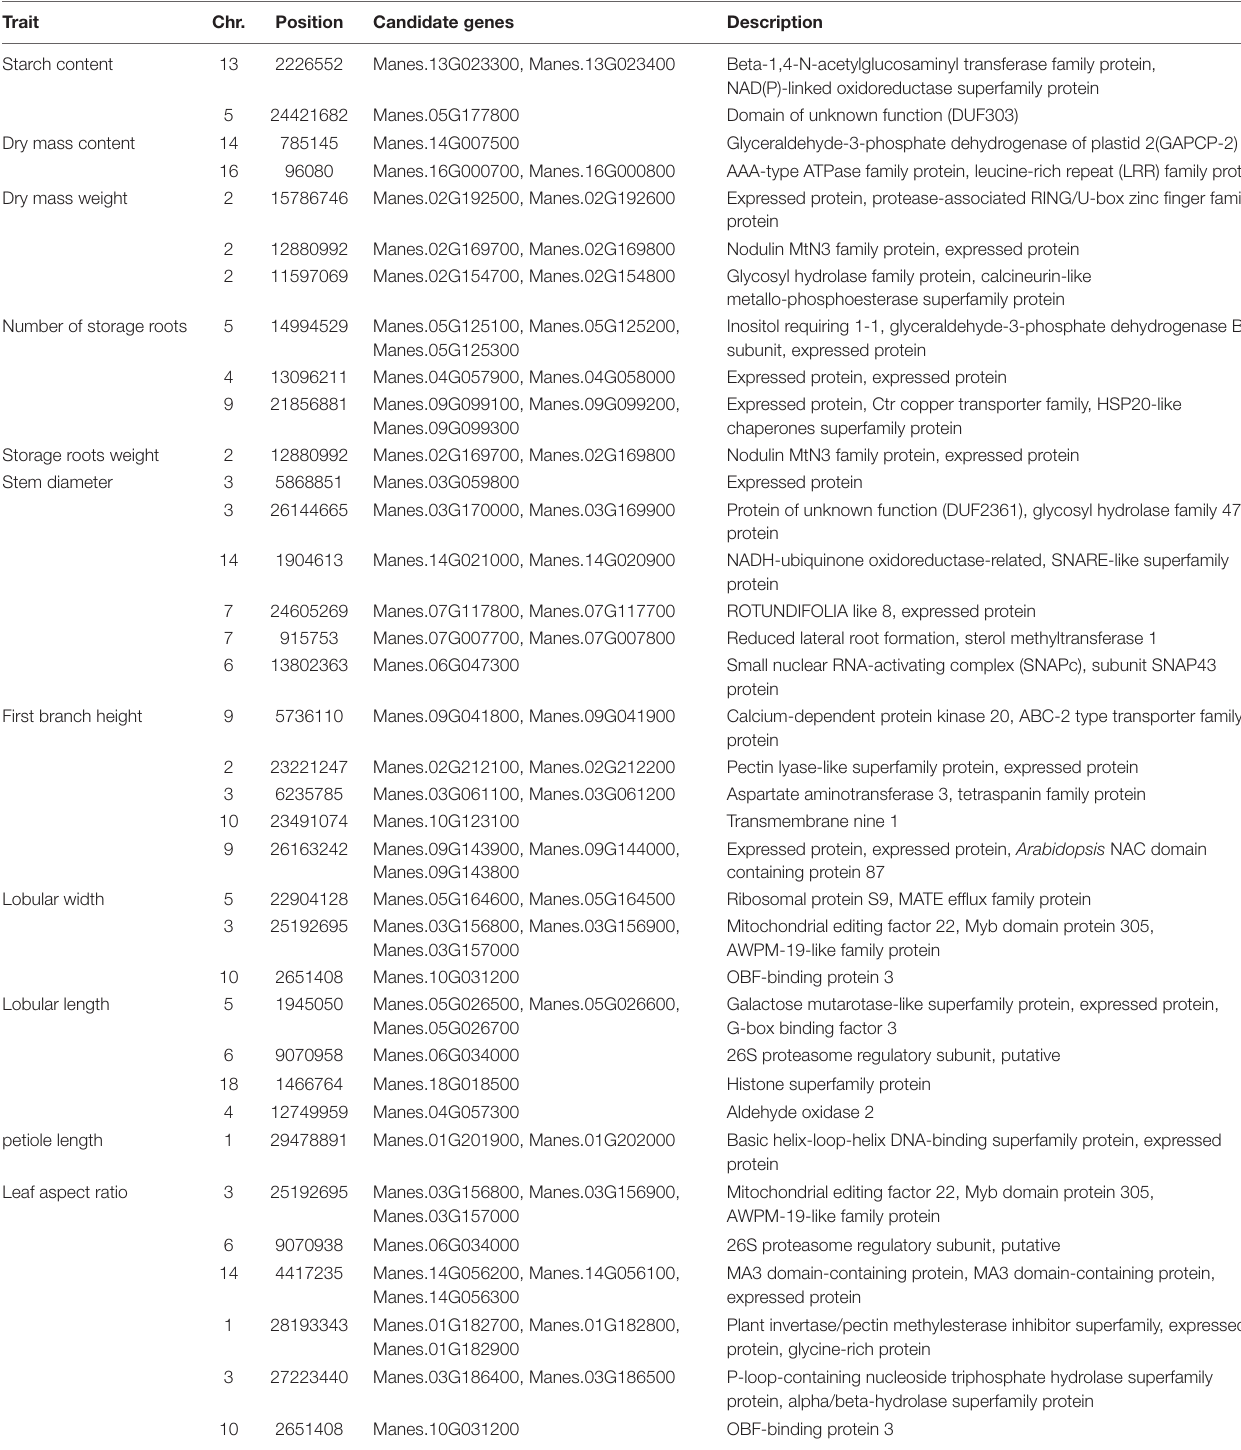
TABLE 3 | Associated loci and candidate genes according to gene